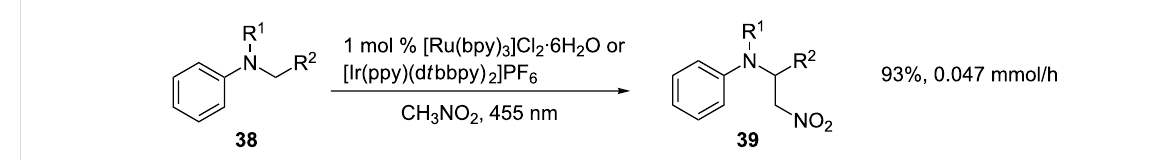
Scheme 14: Photocatalytic aza-Henry reactions.